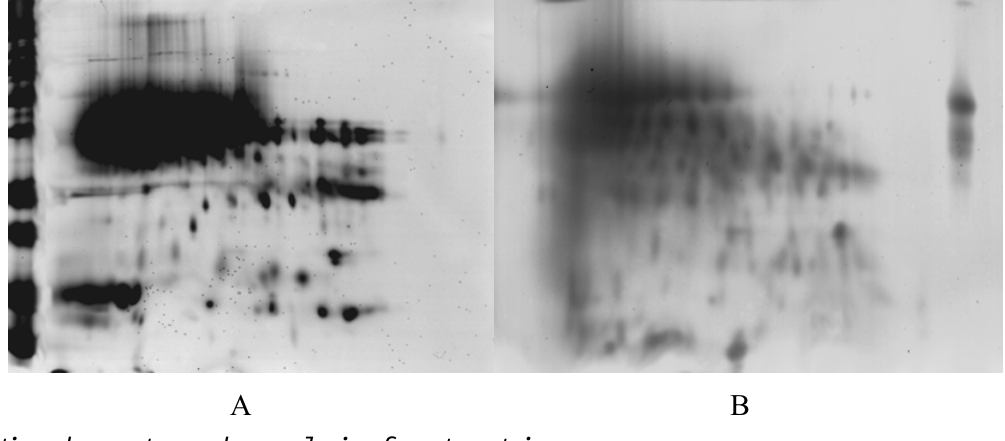
Gel filtration chromatography analysis of wort